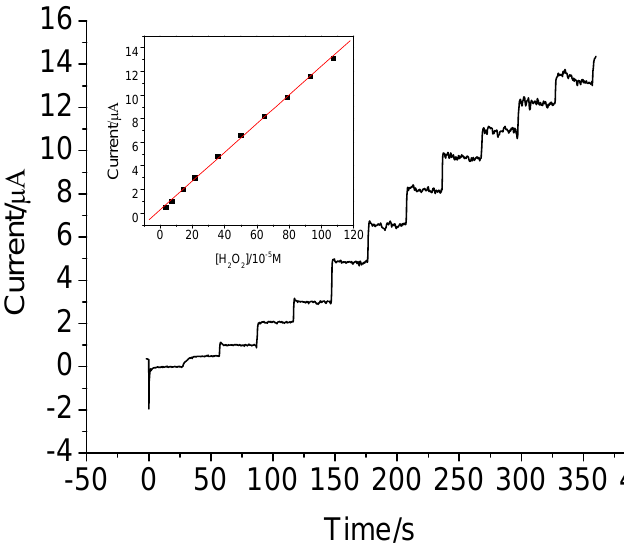
Figure 7 . A typical current-time response curve for successive additions of 10, 10, 20, 20, 40, 40, 40, 40, 40, 40 and 50 µL 35.8 mM H PBS. Applied potential: -100 mV. The insert plot shows a calibration curve of current with O H 2 2